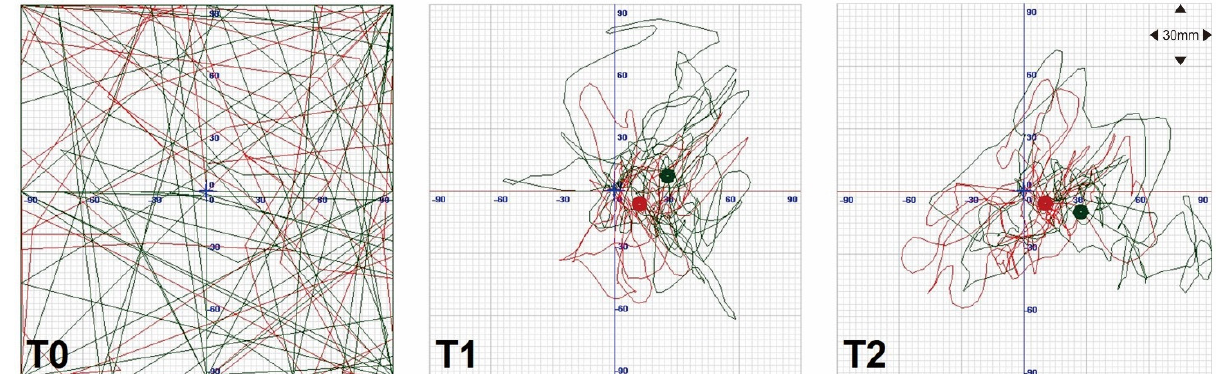
Figure 2. Movement of the center of pressure (COP) with the eyes open (red line) and closed (green line). Before training ( T0 ), the patient could not maintain a stationary position, and the COP moved in a disorderly fashion whether the eyes were open or closed. After ( T1 ) and 4 weeks after the end of the program ( T2 ), the patient could maintain a relatively static COP compared to T0.